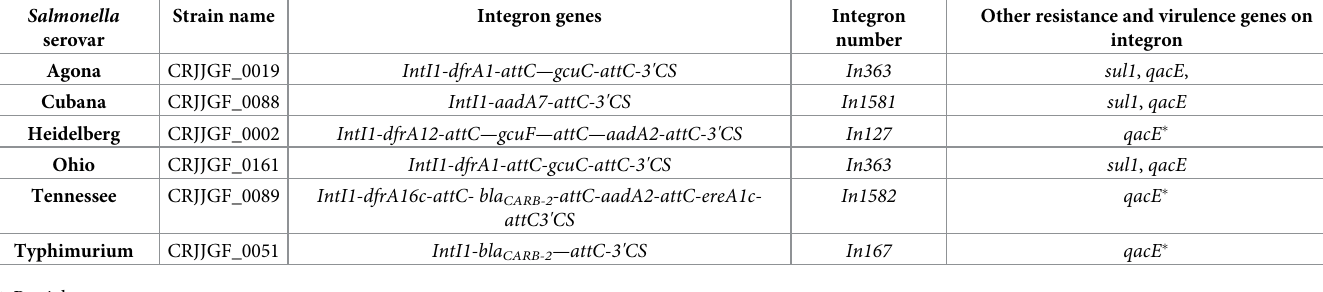
Table 3. Class 1 integrons identified in different Salmonella